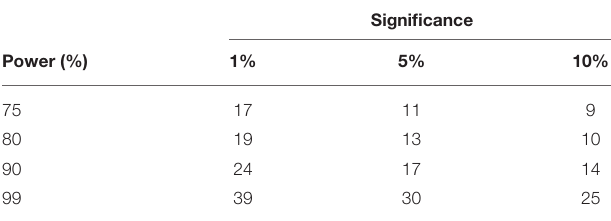
TABLE 4 | Required sample sizes to identify significant difference between treatment effects.